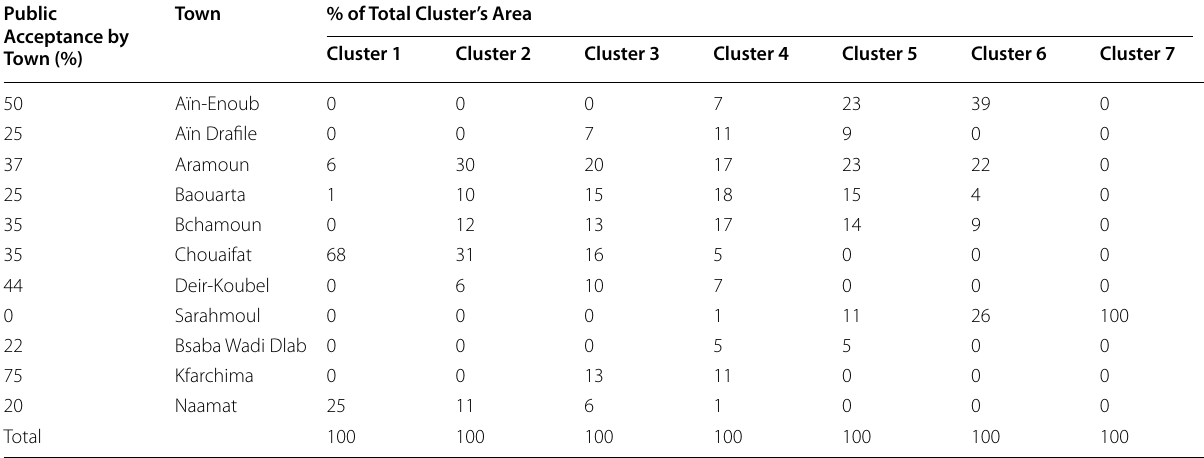
Table 8 Public acceptance rate of the BRT and town surface distribution over Clusters (% of Total Cluster’s Area)